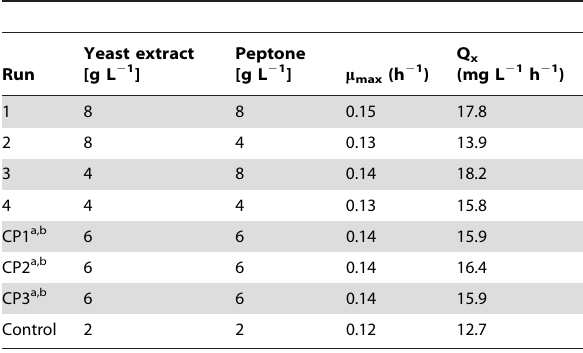
Table 4. Maximum volumetric productivities (Q x ) and growth rates ( m max ).